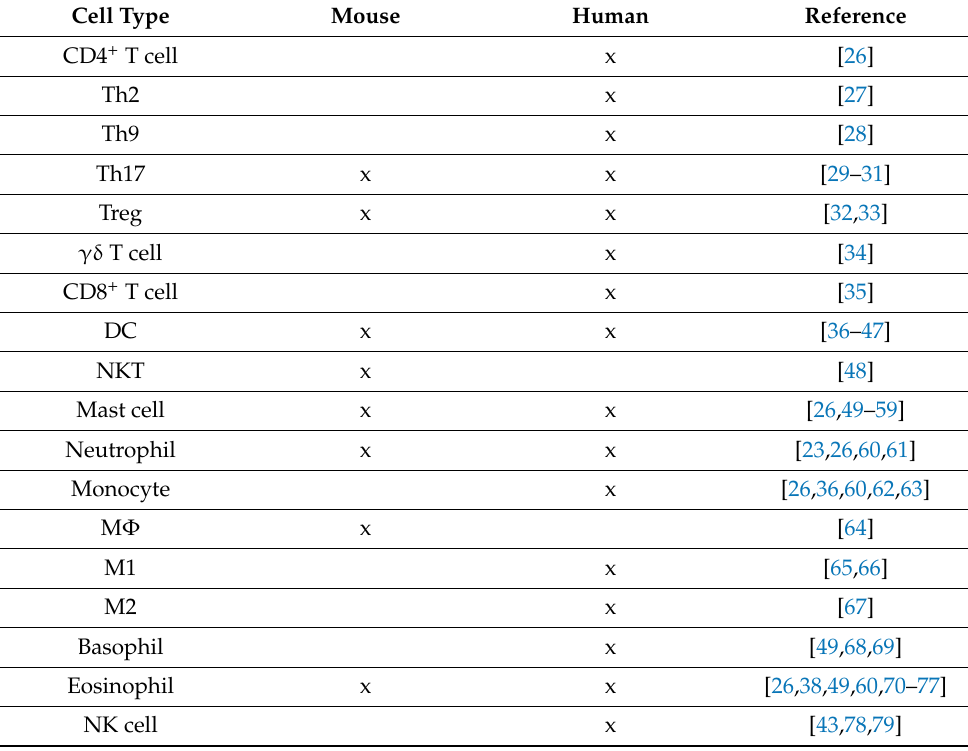
Table 1. Expression of H 4 R in immune cells (mRNA and/or functional